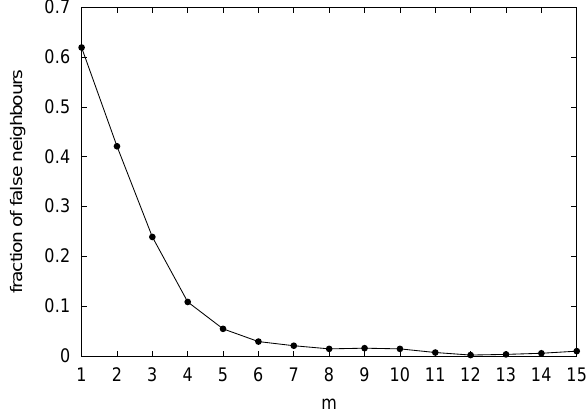
Fig. 2. The fraction of the closest false neighbours as a function of the embedding dimension m for the time